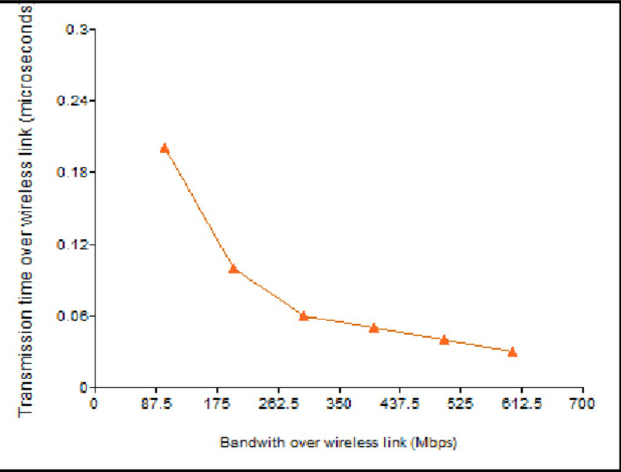
Fig 8. Message transmission time vs bandwidth over the wireless